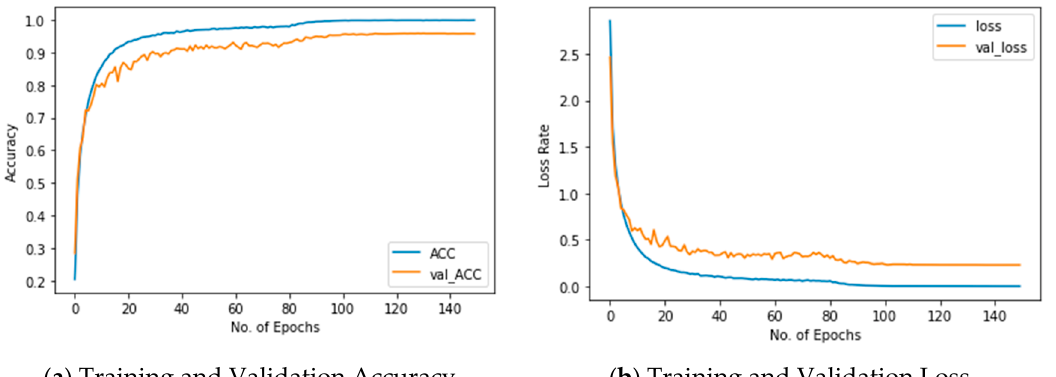
Figure 4. ( a ) training and validation accuracy and ( b ) training and validation loss of the optimized CNN model on the augmented dataset.